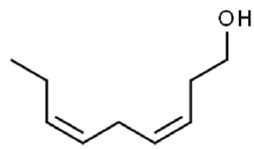
Figure 12. Chemical structure of (E)-2-Nonenal and (Z)-3-Hexenal.